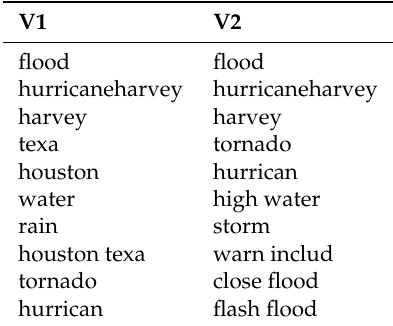
Figure 3. Relative frequency of the ten most frequent terms in the hurricane dataset on the day of the event compared to their relative frequency in the comparison dataset of a normal day. Table 5. Results of the two proposed variants V1 (union vocabulary) and V2 (difference vocabulary) for automatically determining seed words on the hurricane dataset.